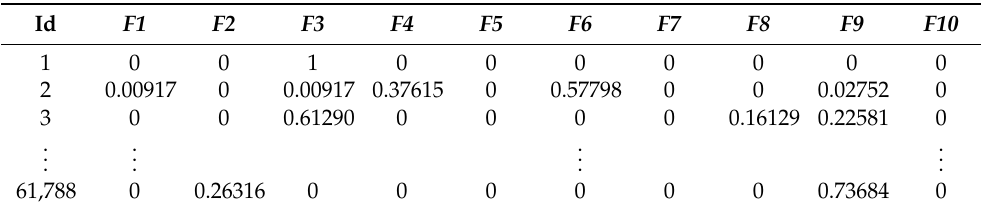
Table 3. Excerpt of the feature table of the grounds where the 61,788 pedestrians